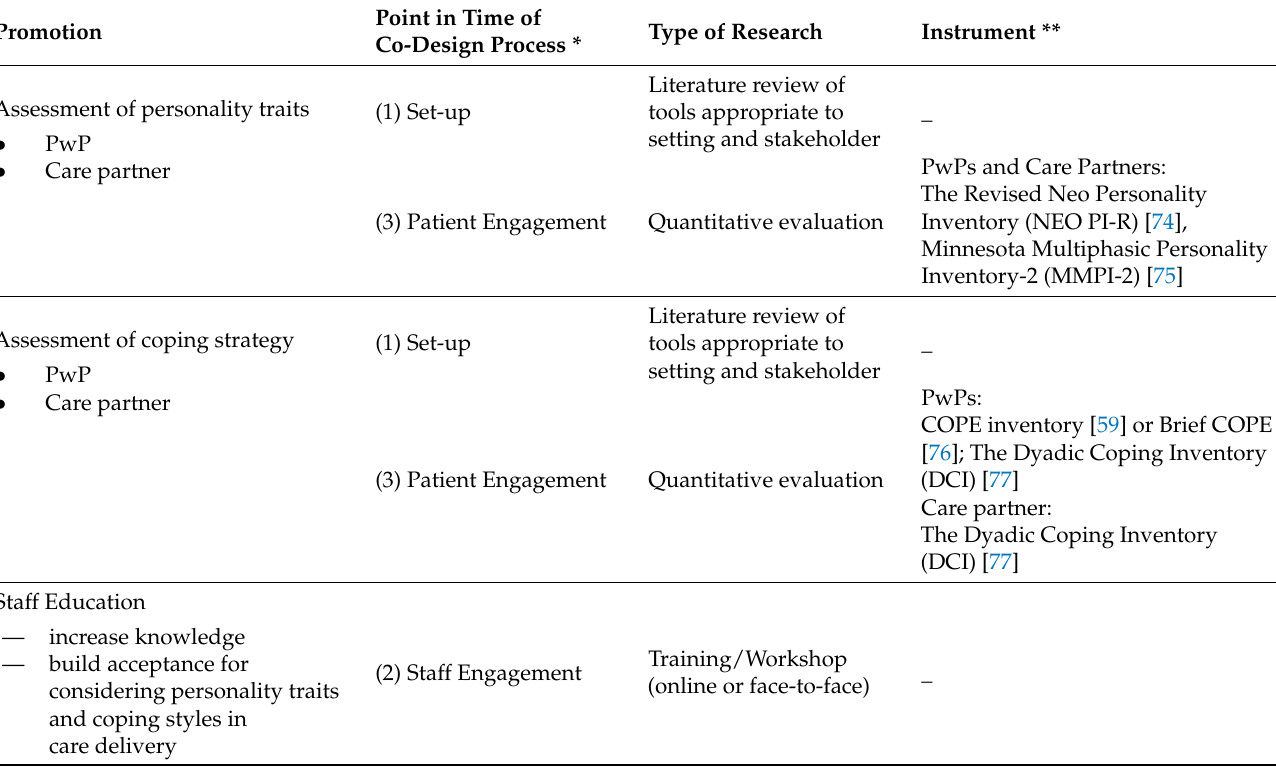
Table 2. Proposed framework to adopt personality traits and coping styles in the development of integrated care